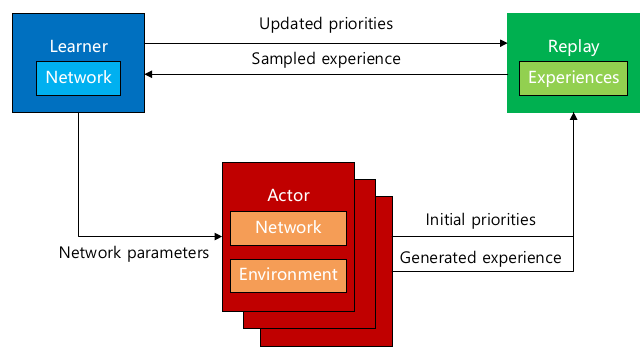
Figure 3. Architecture of the Ape-x algorithm.